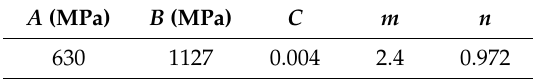
Table 6. Obtained material constants of in-situ TiB 2 /7050Al MMC.